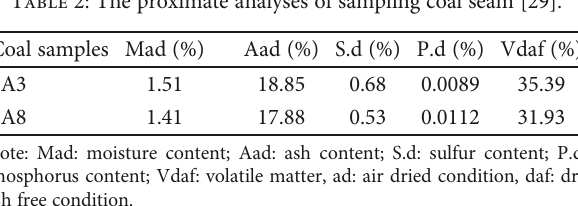
Table 2: The proximate analyses of sampling coal seam [29]. Coal samples Mad (%)